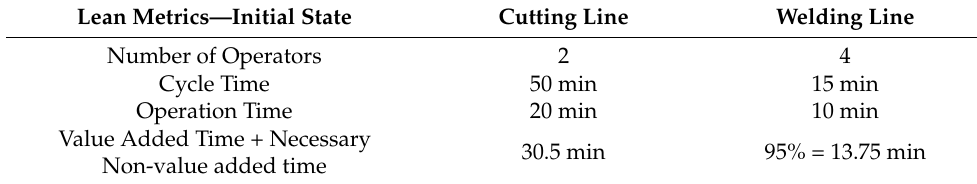
Table 2. Data from the initial state of the production process.